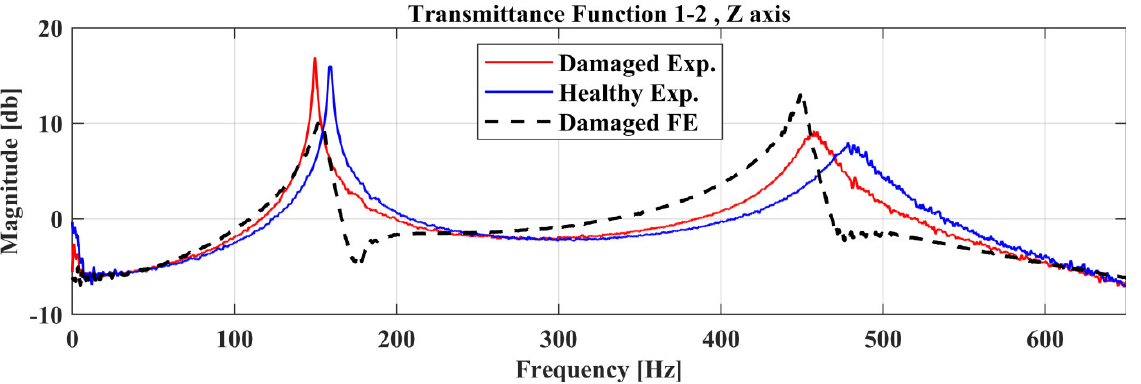
Figure 21. Comparison of the Transmittance Functions 1-2 between the damaged and healthy ex- perimental measurements along with the damaged FE Model.